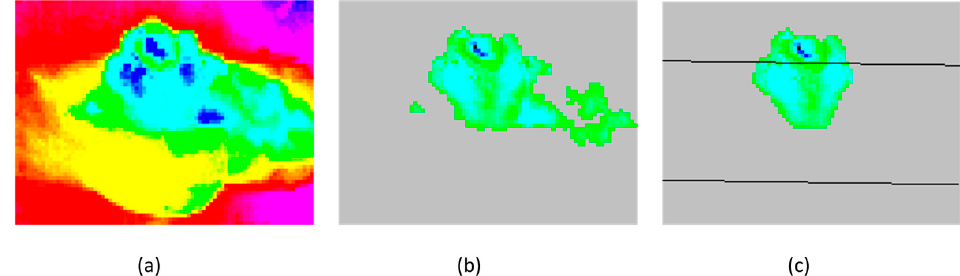
Figure 3. Background heat removal and heat disposal algorithms: ( a ) Frame with person in bed; ( b ) Same as ( a ), but with applied background heat removal algorithm; ( c ) Same as ( b ), but with applied heat disposal algorithm and superimposed representation of bed.